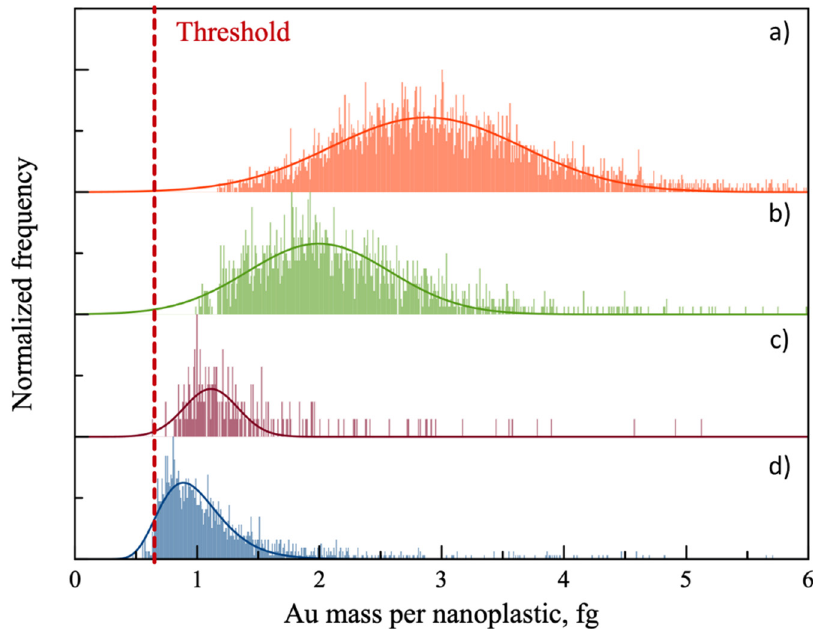
Figure 6. Au mass distributions obtained for samples made of a mixture of ( a ) PSAA22; ( b ) PSAA18; ( c ) PSAA13 and ( d ) PSAA9 nanoplastic model materials with AuNPs@gel. The red line represents the threshold discriminating between labelled nanoplastics and not bound AuNPs@gel in the sam- ple. Table 2. Expected nanoplastic number concentration and nanoplastics number concentration ob- tained by SP-ICP-MS for different nanoplastic model materials.